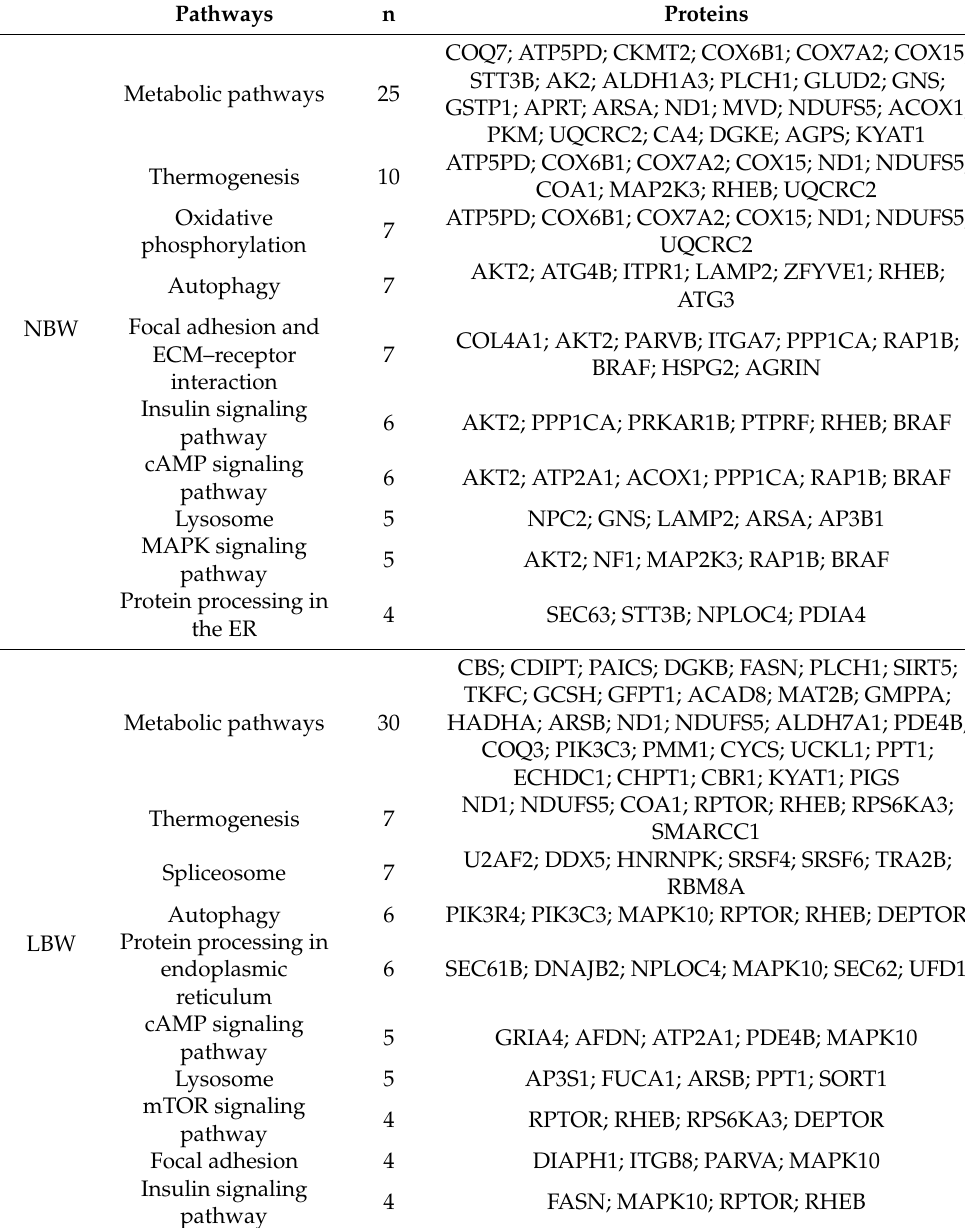
Table 4. List of the most representative differential proteins involved in the response of NBW and LBW pigs to an HFD identified by KEGG pathway